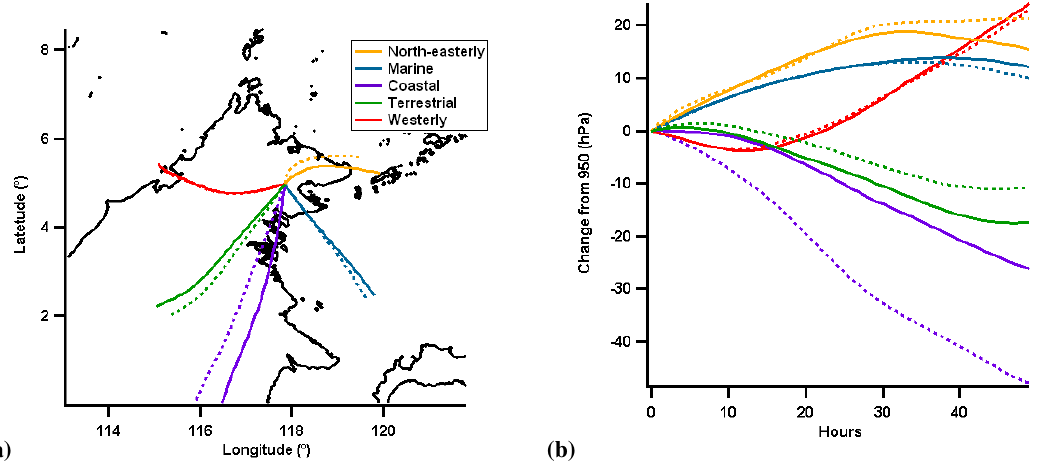
Fig. 4. OP3-I cluster mean (a) latitude and longitude and (b) pressure altitude in units of hPa different from starting altitude of 950 hPa. Colours are consistent between plots. Solid and dashed lines show solutions from each subset.